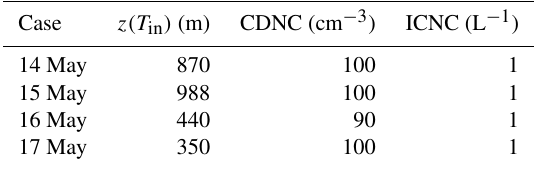
Table 1. Model setup specifications of the different mixed-phase cloud simulations of 4 VERDI campaign